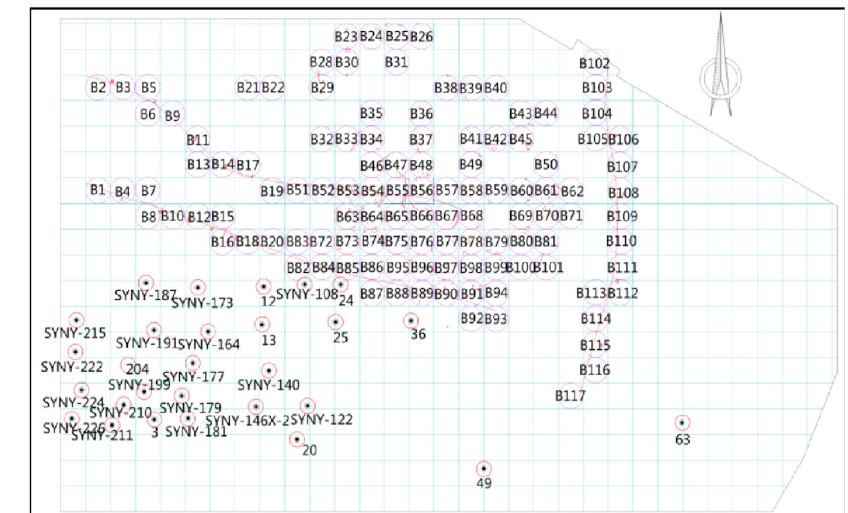
Figure 10: Structural grid and borehole distribution